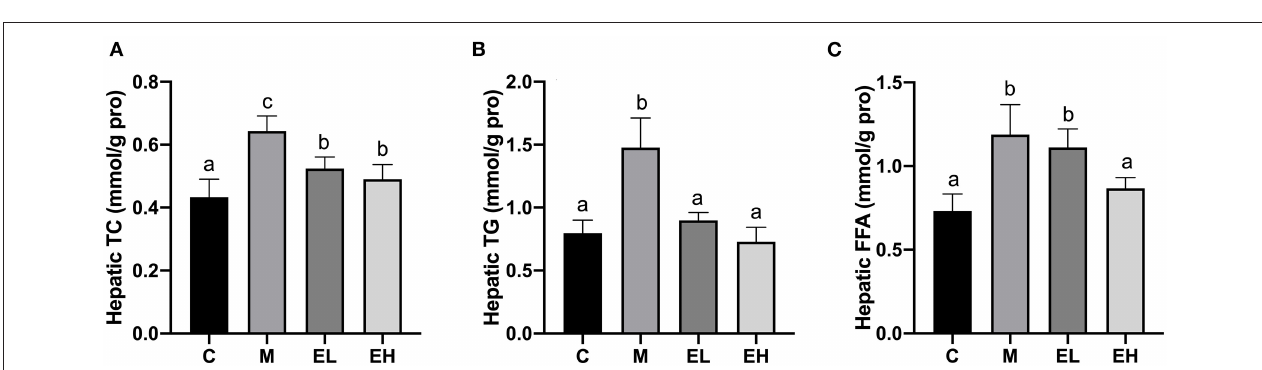
FIGURE 2 | Effect of ellagic acid on serum lipid profile in mice. (A) TC; (B) TG; (C) FFA; (D) HDL-C; (E) LDL-C. Values represent the mean ± SD ( n ≥ 6). Labeled means without a common letter difference. p < 0.05 by one-way ANOVA followed by Duncan’s test. C, normal group; M, model group; EL, low dose of ellagic acid group; EH, high dose of ellagic acid group.